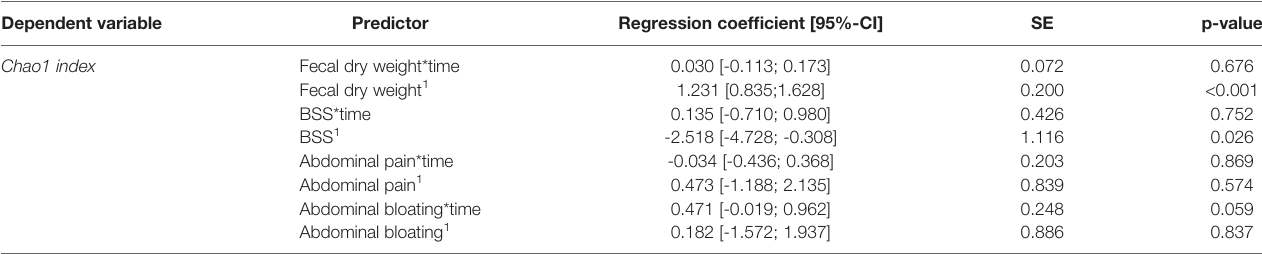
TABLE 3 | Results of linear mixed-effects models.